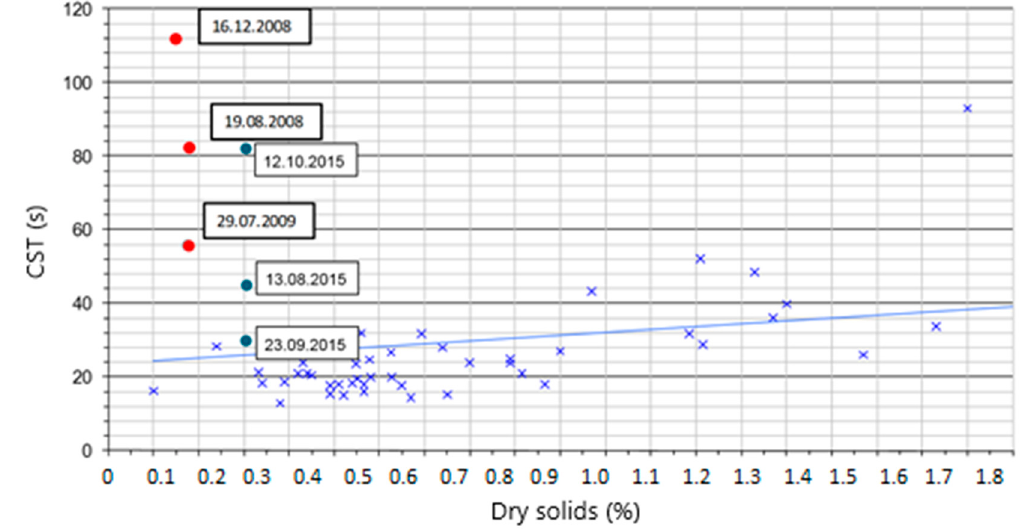
Figure 10. Capillary suction time (CST) of surplus activated sludge (blue X) and sludge from the Hanningfield WW (red dots) and Whitacre WW (blue dots) [53].